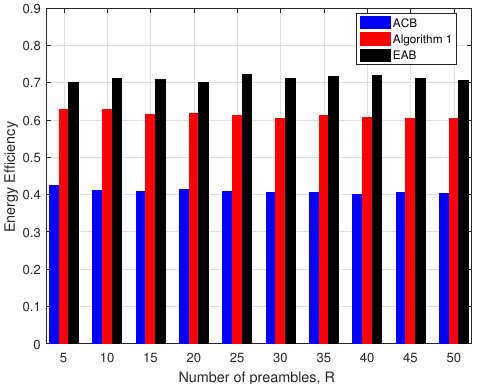
Figure 9. EE’ vs. number of preambles, R